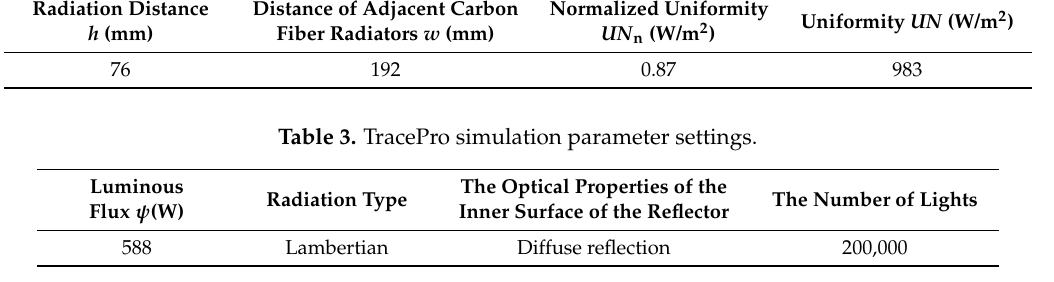
Table 2. Optimization parameters of thermal excitation source.